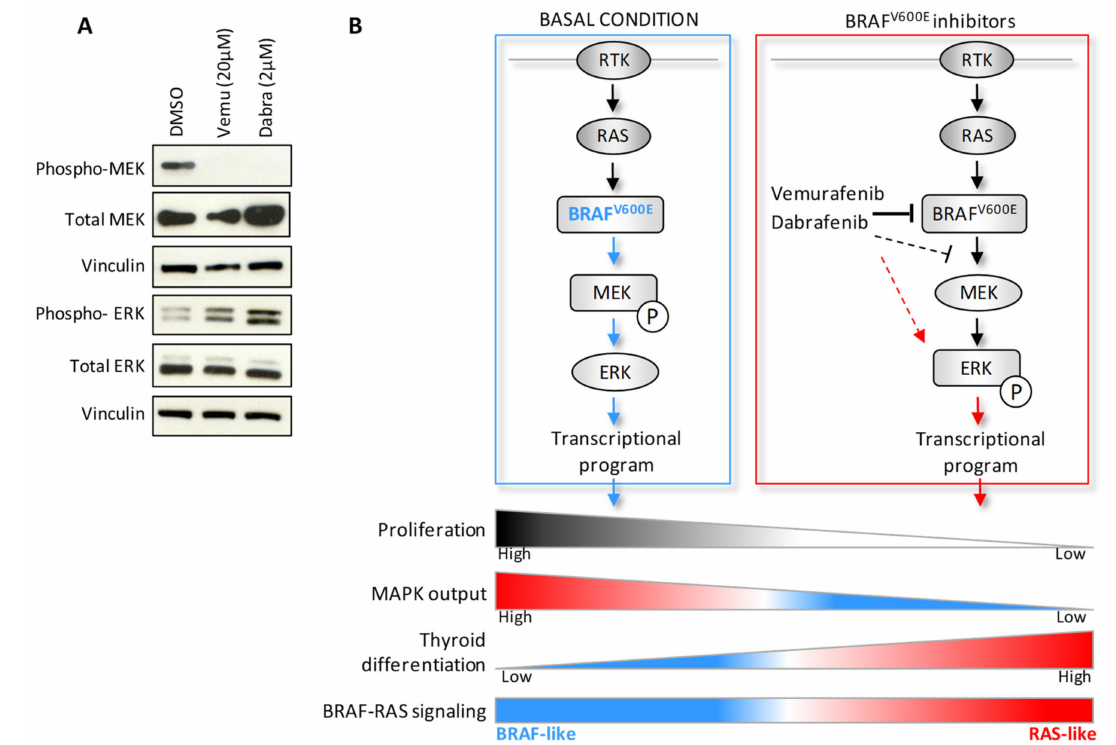
Figure 7. Alternative MAPK pathway activation upon treatment with BRAF inhibitors in BCPAP cells. ( A ) Western blot analysis in BCPAP cells treated with Vemurafenib or Dabrafenib for 48 h compared to control cells treated with vehicle DMSO. Vinculin included as protein loading control. ( B ) Schematic representation of the expression pattern identified by transcriptomic and biochemical analyses in BCPAP cells treated with BRAF